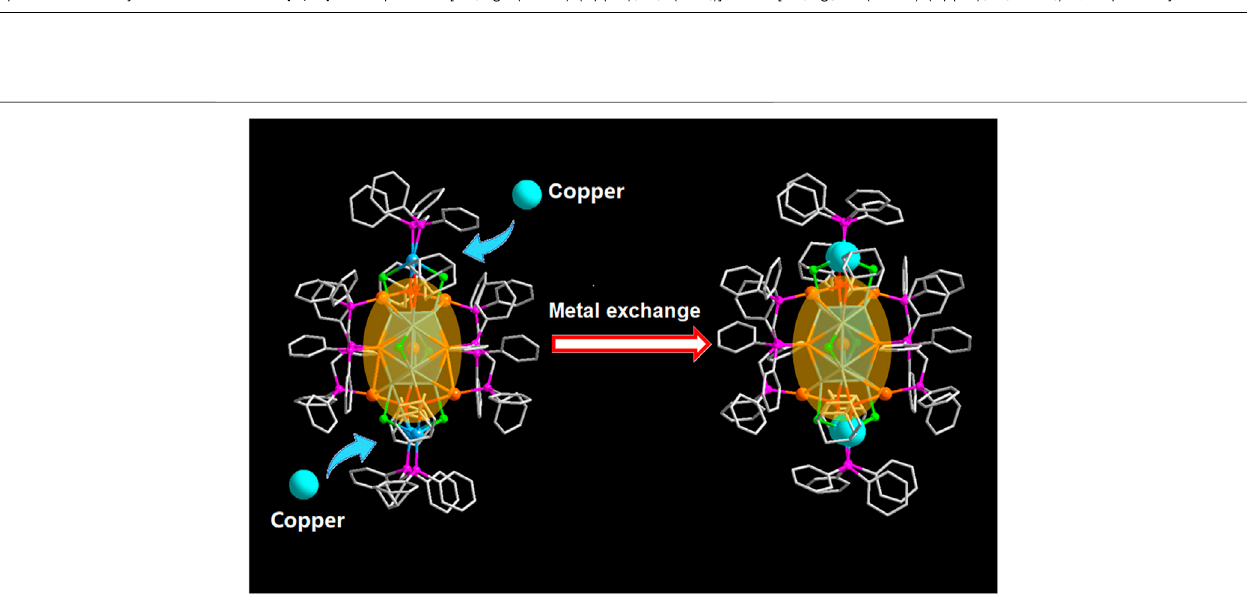
SCHEME1 | The metal exchangefrom [Au9Ag12(SAdm)4(Dppm)6Cl6](SbF6)3 to[Au9Ag8Cu4(SAdm)4(Dppm)6Cl6](SbF6)3 (Color labels: Golden (cid:1) Au; Skyblue (cid:1) Ag; red (cid:1) S; purple (cid:1) P; Gray (cid:1) C; light green (cid:1) Cl; Turquoise (cid:1) Copper).